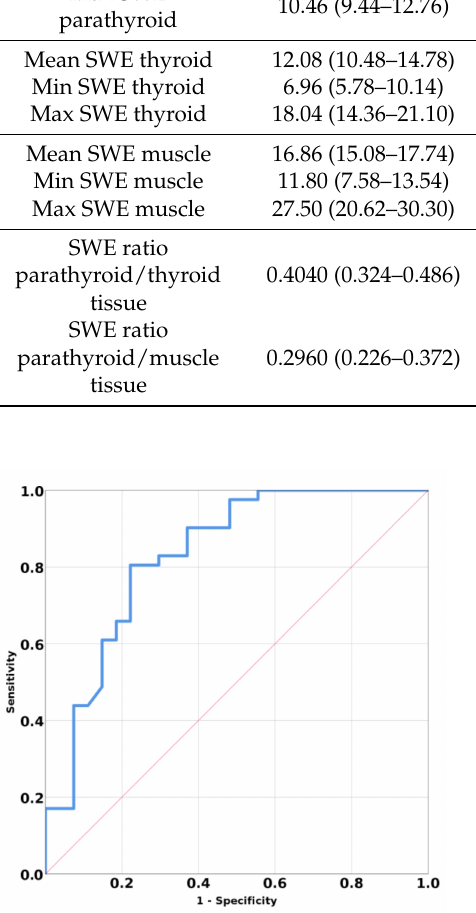
Figure 4. Area under curve (AUC) for prediction means SWE of primary hyperparathyroidism versus secondary